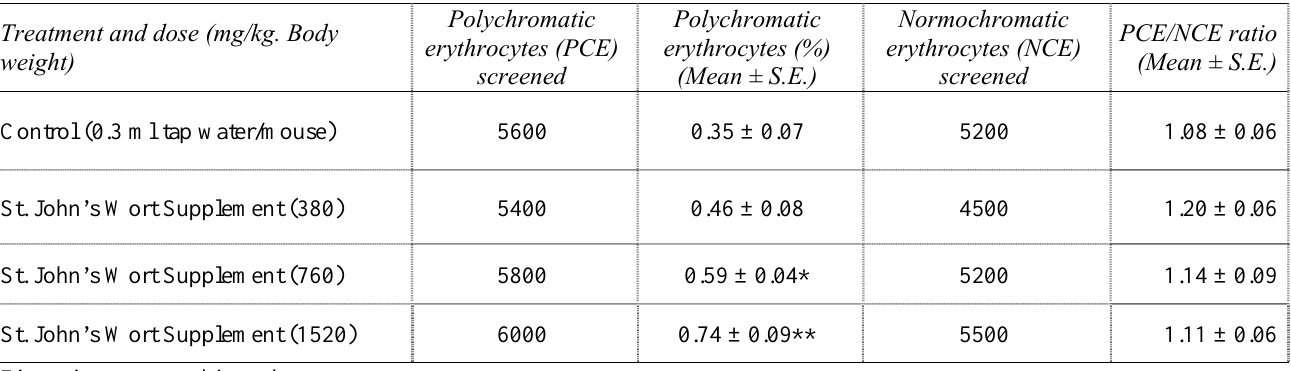
Table 1 : Effect of St. John’s Wort Supplement on the frequency of micronuclei and the ratio of polychromatic to normochromatic erythrocytes from femoral bone marrow of Swiss albino mice after sub-acute treatment Treatment and dose (mg/kg. Body